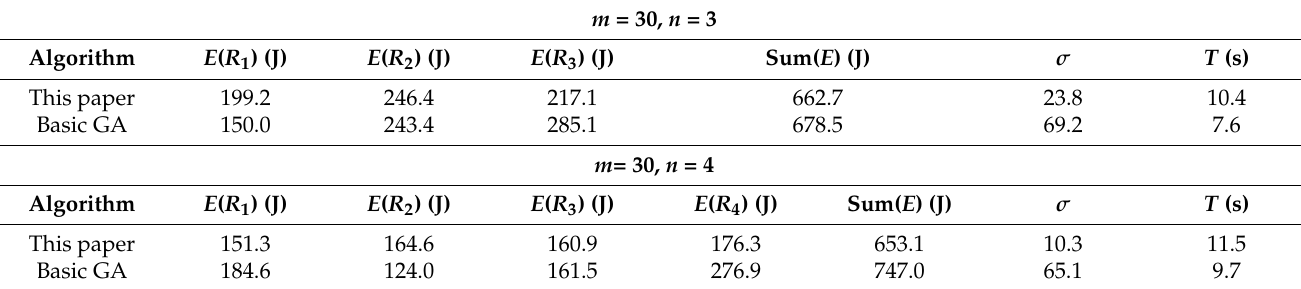
Table 1. Comparison of algorithm parameters from Experiment 1. m = 30, n = 3